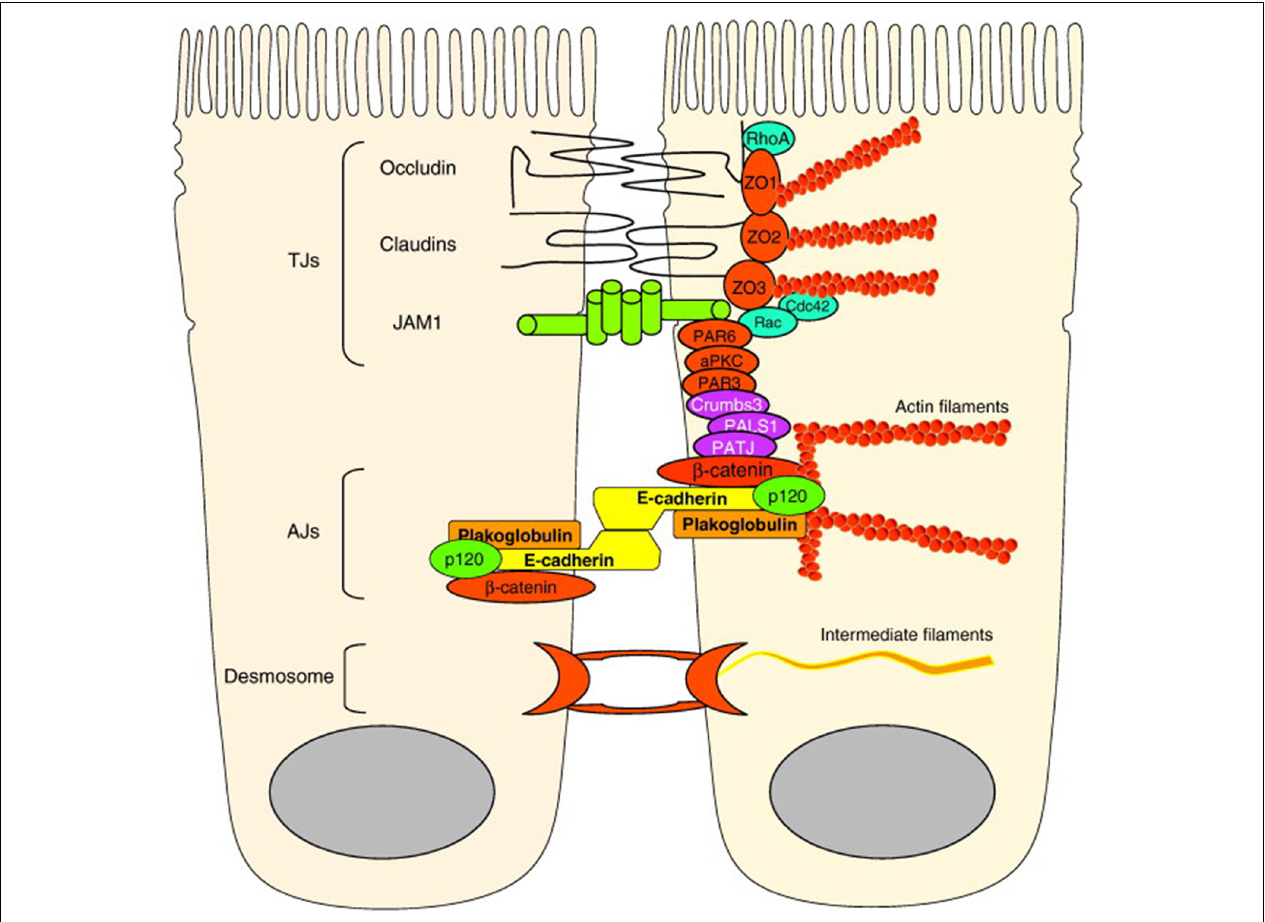
FIGURE 2 | Molecular structure of airway epithelial barrier: TJs are localized apically and include transmembrane proteins claudins, occludin and JAMs. JAMs bind the cell polarity proteins Par-3 and Par-6. AJs localization is below the TJs and more basolaterally and their main component is E-cadherin, which interacts with the cytoplasmic proteins p120 catenin, β -catenin, and α -catenin to connect with the actin cytoskeleton. Desmosomes are also localized most